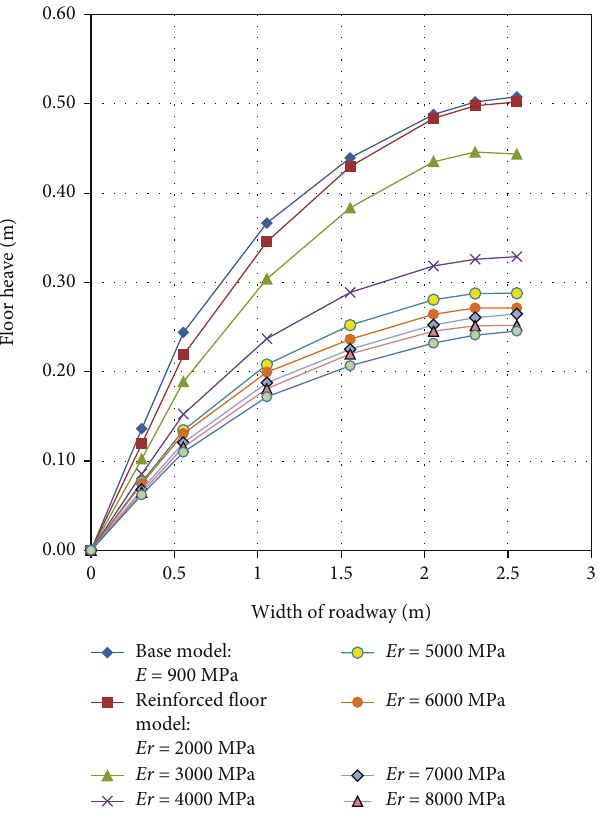
Figure 13: Graphs of the in fl uence of elastic modulus of the reinforced fl oor rock ( E r ) on the roadway fl oor heave according to the results of numerical modeling.